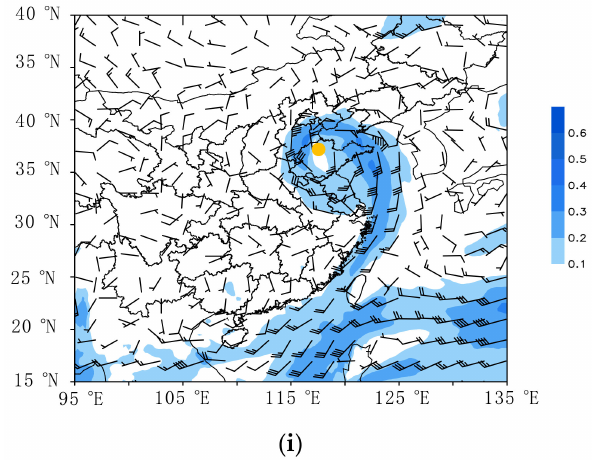
Figure 6. ( a – c ) 200-hPa geopotential height (blue contour, unit: dagpm), wind barb and wind speed (shaded, ≥ 20 m s − 1 ); ( d – f ) 500-hPa geopotential height (blue contour, unit: dagpm), 850-hPa wind barb and wind speed (shaded, ≥ 12 m s − 1 ); ( g – i ) 925-hPa water vapor flux (shaded, unit: 10 − 4 g cm − 1 hPa − 1 s − 1 ) and wind barb at ( a , d , g ) 0800 BT on 24 July 2021, ( b , e , h ) 2000 BT on 26 July 2021, and ( c , f , i ) 2000 BT on 29 July 2021. The location of TC centers are shown by orange dots.